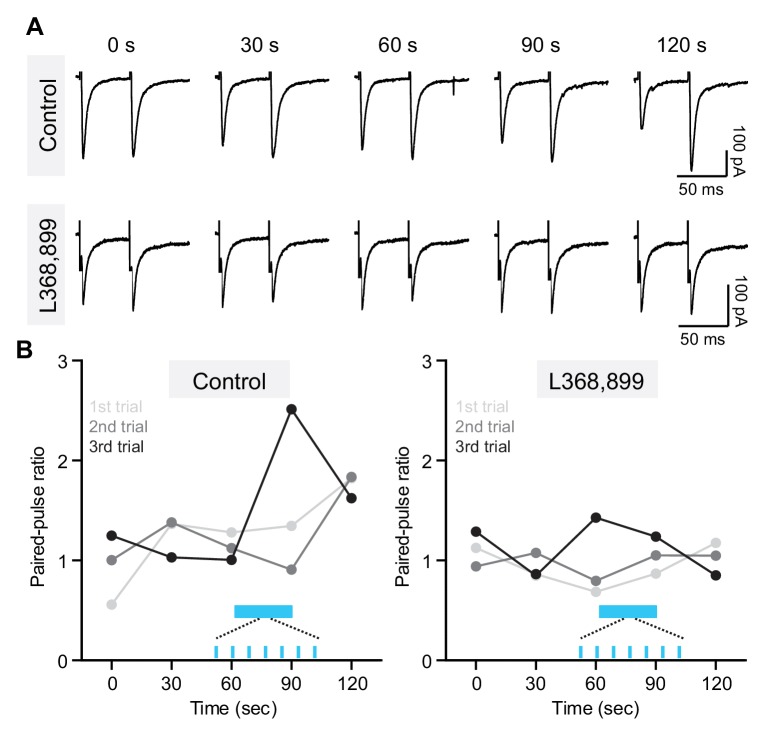
Optical stimulation of oxytocinergic fibers in VTA modulates paired-pulse ratio of evoked EPSCs in DA neurons.(A) Top: traces from a VTA DA neuron showing pairs of EPSCs (50 ms ISI) before and after light stimulation. Light stimulation was delivered at t = 60–90 s. (B) Left: Example of light stimulation-induced EPSC PPR changes across three sequential trials from one VTA DA neuron. Inter-trial interval was 6 min. Right: Same as left, but in the presence of OxtR antagonist (L368,899).